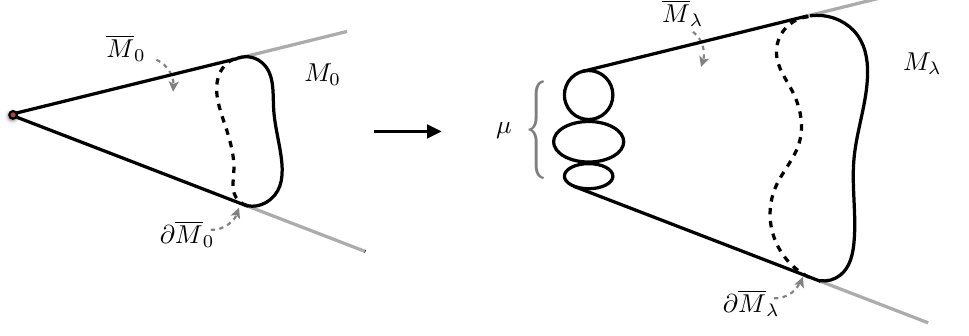
Figure 3 . An illustration of the deformation of a conical singularity to a bouquet of (cid:22) spheres, when passing from the homogeneous function f ( z ) to the unfolding F ( z; t ) in (4.6). The point-like singularity is replaced by a deformed space that features nontrivial cycles, which vanish when the deformation parameters t a are switched